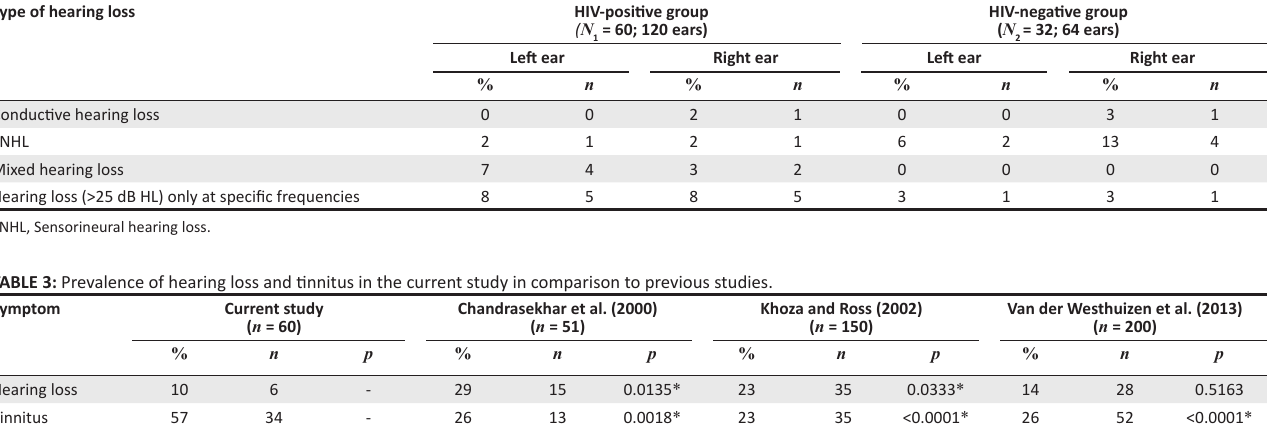
TABLE 2: Presence and nature of hearing loss. Type of hearing loss